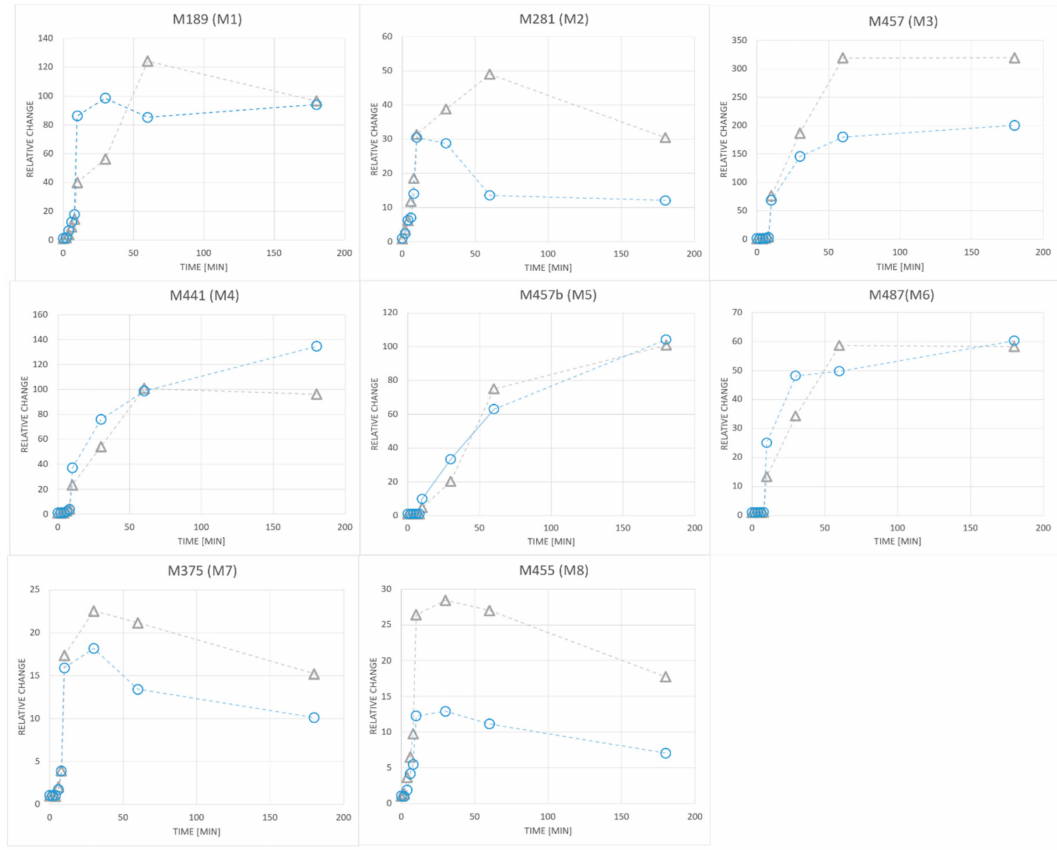
Figure 5. The relative changes of peak areas of metabolites in plasma of two volunteers after administration of ANT. The molecular weights of metabolites are given in Table 1. Only the compounds with increased intensities greater than 10, in at least three sampling points, are presented.